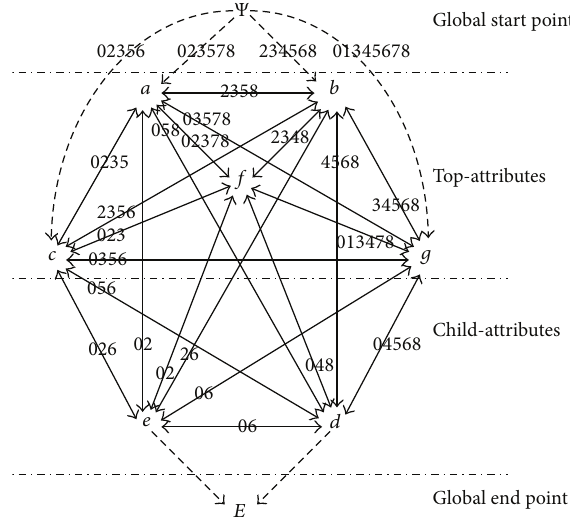
Figure 2: The topological degeneration model from the topology shown in Figure